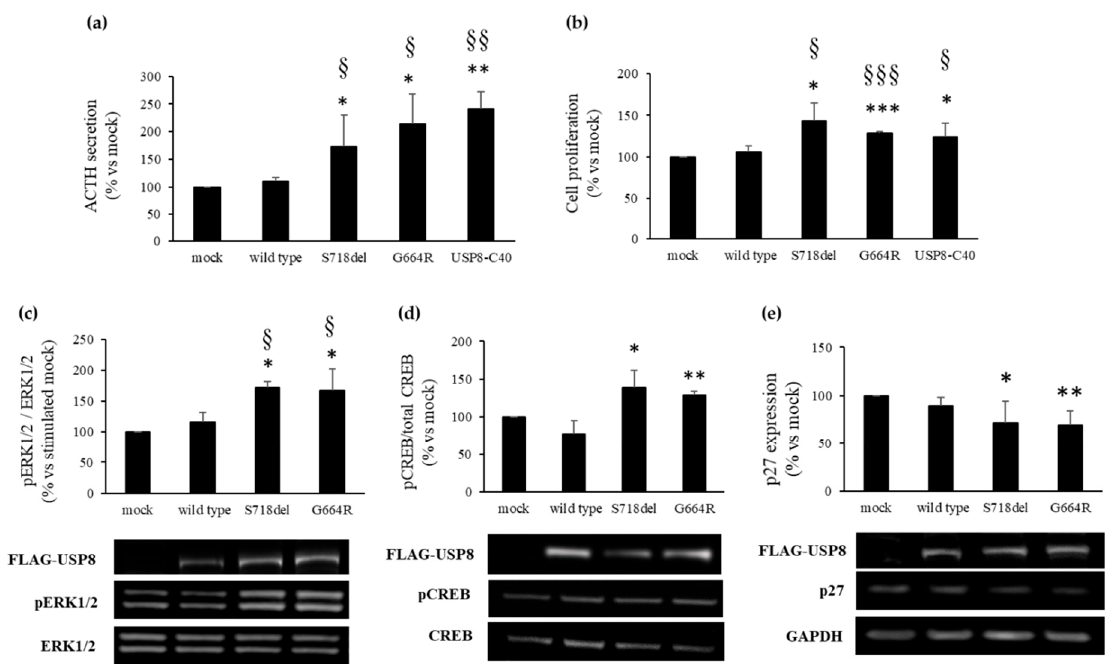
Figure 2. Effects of USP8 G664R variant on hormone secretion and cell proliferation. ( a ) ACTH released in culture medium from AtT-20 cells transiently transfected with USP8 constructs was measured by competitive ELISA kit. Each determination was done in triplicate. ( b ) Cell proliferation results of AtT-20 cells transfected with USP8 constructs by BrdU assay. Each determination was done in quintuple. ( c ) Graphs showing densitometrical analysis of p-ERK1/2 expression levels in AtT-20 cells transiently transfected with USP8 constructs and stimulated with EGF 50 nM for 48 h. ( d , e ) Graphs resulting from densitometrical analysis of p-CREB and p27/kip1 expression levels in AtT-20 cells transiently transfected with USP8 constructs. Values represent mean ± SD and results are expressed as percentage of empty vector transfected cells (mock). *, p < 0.05, **, p < 0.01, ***, p < 0.001 vs. mock; §, p < 0.05, §§, p < 0.01, §§§, p < 0.001 vs. WT USP8 transfected cells.